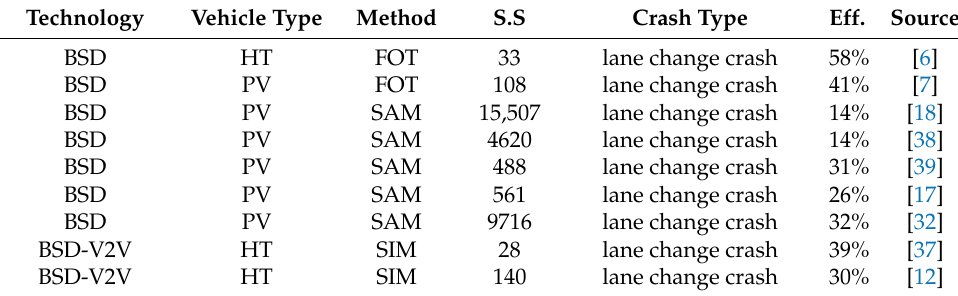
Table 4. Evidence for the crash avoidance effectiveness of BSD.